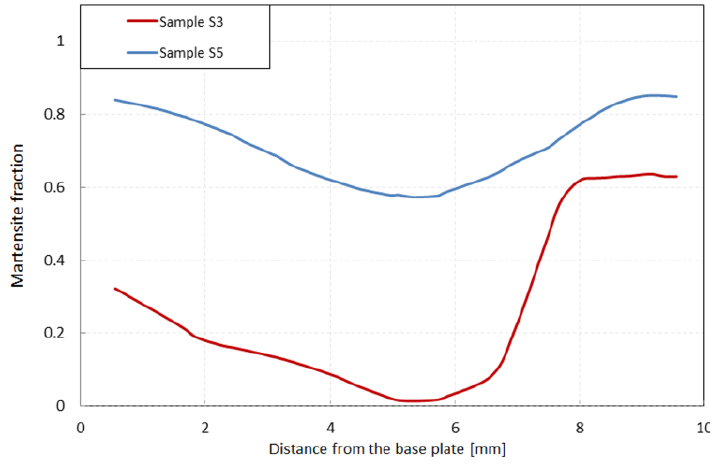
Figure 13. Calculated final α m fraction along a vertical line at the center of the samples S3 and